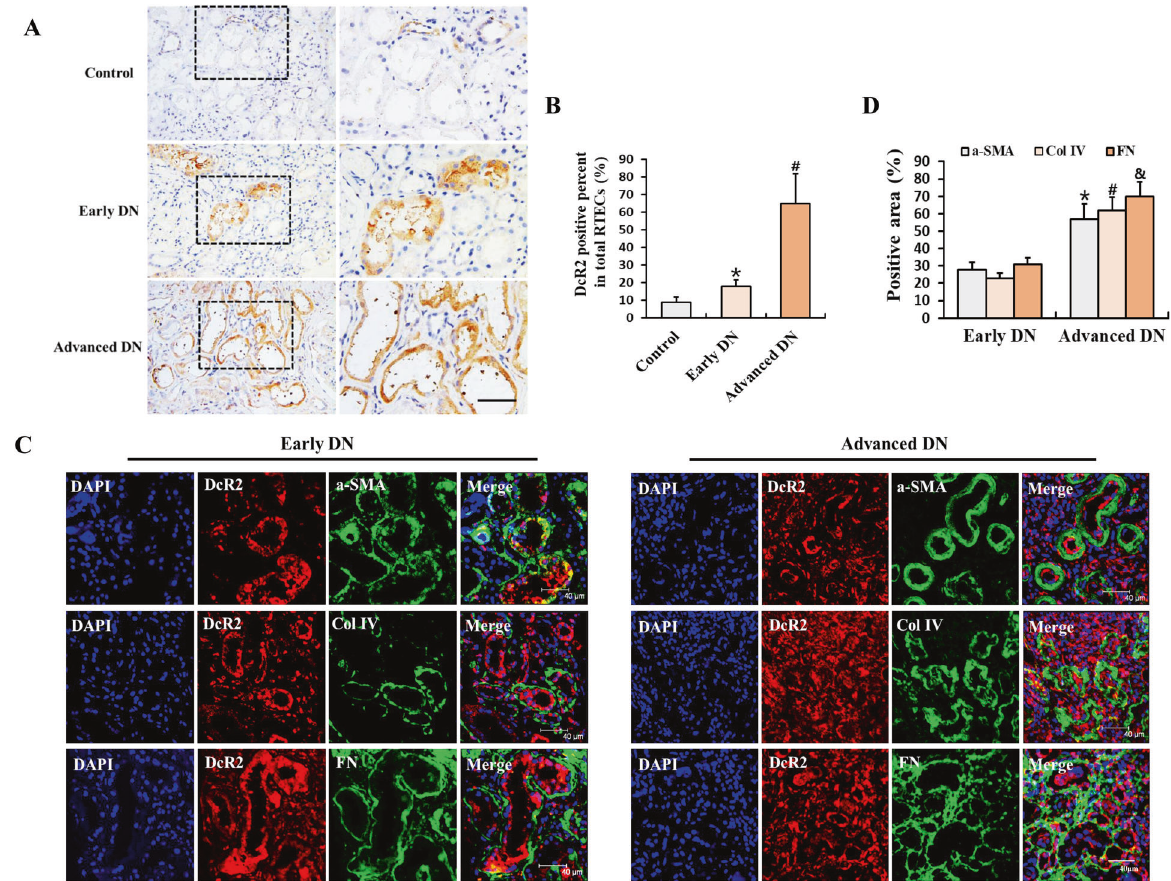
Fig. 1 Analysis of DcR2 expression and co-localization with fi brotic markers in patients with DN. A Immunohistochemical staining for DcR2 in controls and patients with DN. Scale bar, 40 μ m. B The percentage of DcR2-positive RTECs was quanti fi ed ( n = 241). Data are expressed as the mean ± SD for each group. * P < 0.05 versus control; # P < 0.05 versus early DN. C Representative immuno fl uorescence staining for DcR2 (red) and fi brotic markers ( α -SMA, collagen IV, and fi bronectin) (green) in patients with early and advanced DN. Scale bar, 40 μ m. D